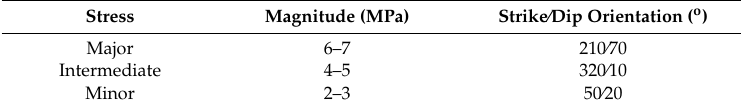
Table 2. In-situ stress estimated from field measurements (based on